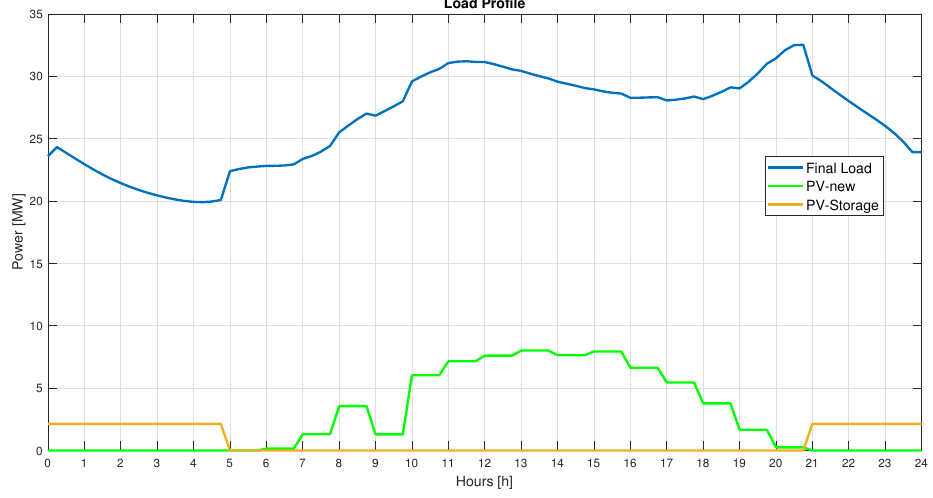
Figure 11. Demand with PV and storage.